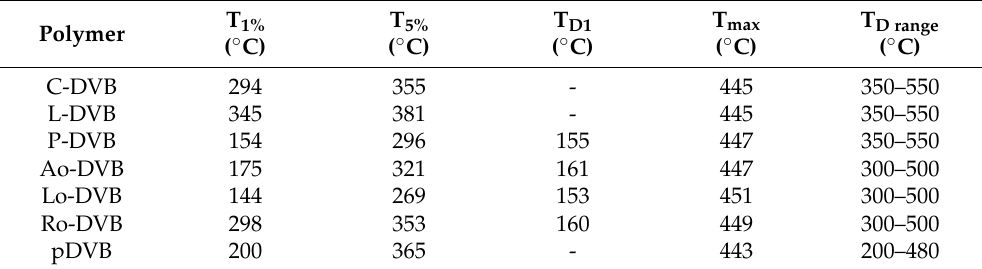
Figure 7. Thermogravimetric analysis results ( a ) C-DVB and L-DVB, and ( b ) Ao-DVB, Lo-DVB, and Ro-DVB. Table 5. Results of thermogravimetric analyses.